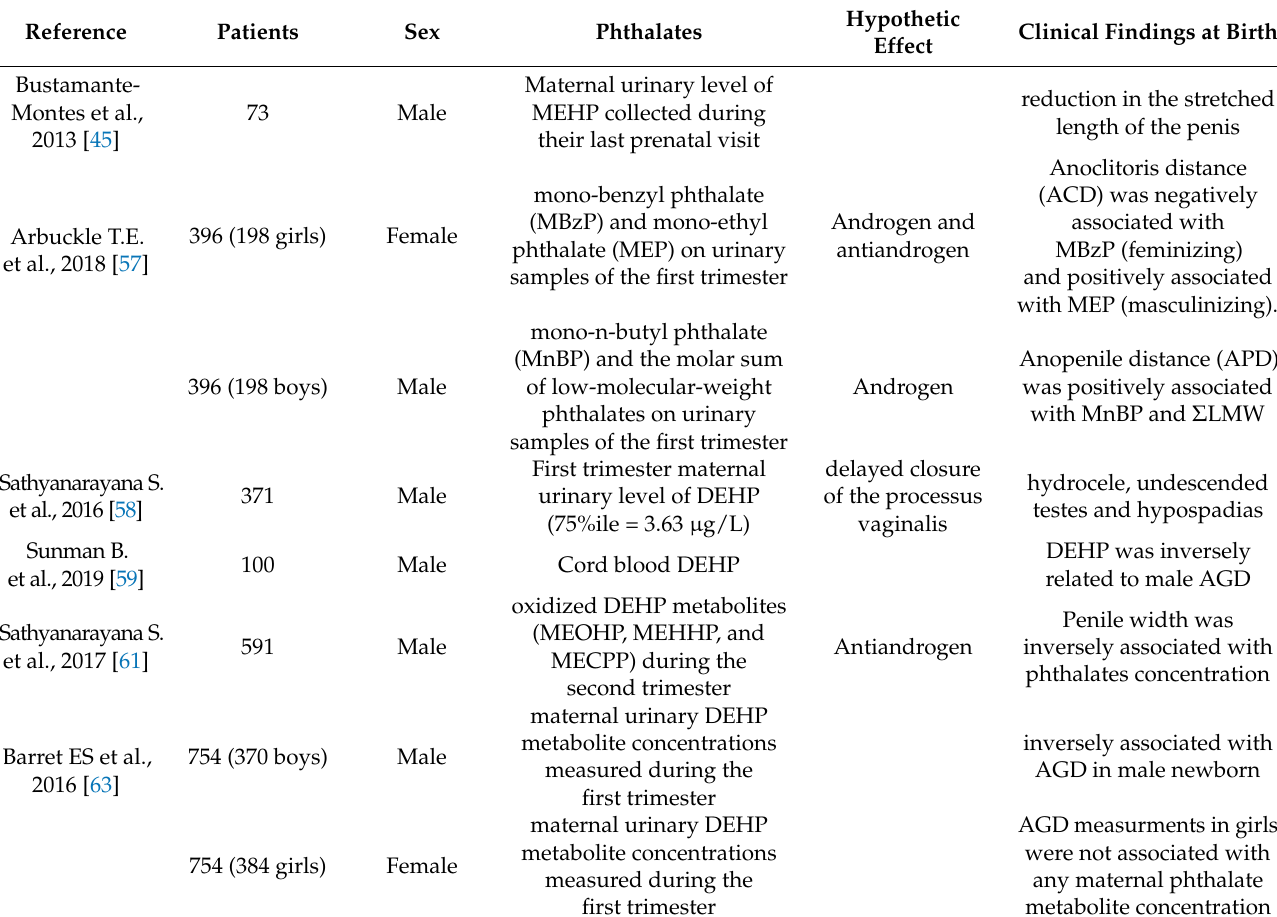
Table 1. Human studies on endocrine effects of phthalates during prenatal life. DEHP: 2-Ethylhexyl phthalate; MEHP: mono(2-ethylhexyl) phthalate; AGD: anogenital distance; MEOHP: mono-(2-ethyl-5-oxohexyl) phthalate; MEHHP: mono (2-ethyl-5-hydroxyhexyl) phthalate; MECPP: methylerythritol cyclodiphosphate; LMW: low molecular weight